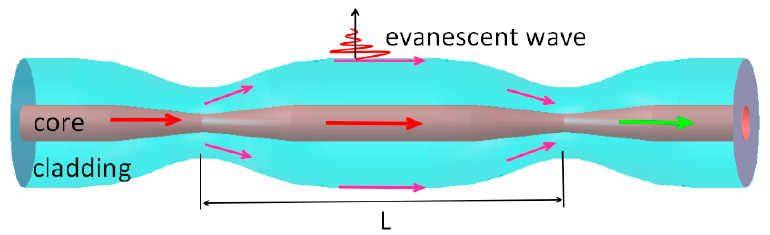
Figure 2. Principle diagram of dual-taper Mach-Zehnder interferometer.